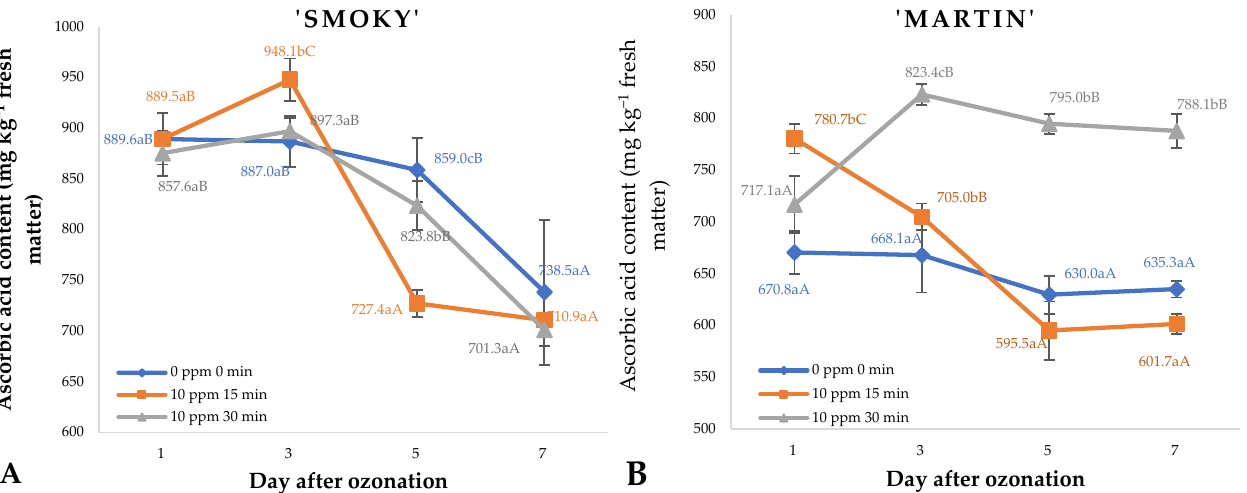
Figure 6. Ascorbic acid contents and standard error of the means in saskatoon berries of ‘Smoky’ ( A ) and ‘Martin’ ( B ) cultivars, relative to the dose of ozone ( n = 3). Note: Differences in results be- tween the dose of ozone on the specific days are indicated by different small letters and difference between assessment days are indicated by different capital letters. Significance level p < 0.05.